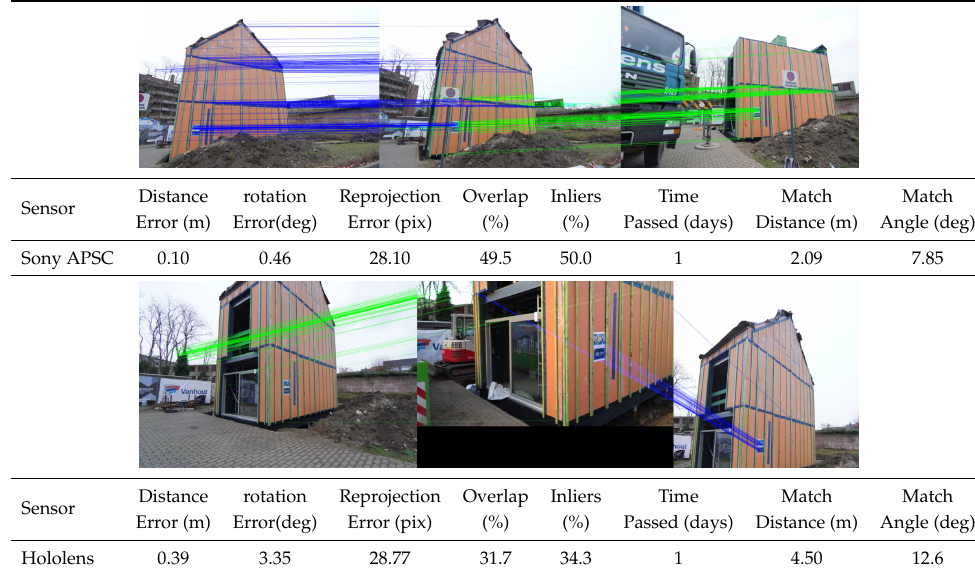
Table 4. Two-dimensional matching estimations based on 2 linked reference